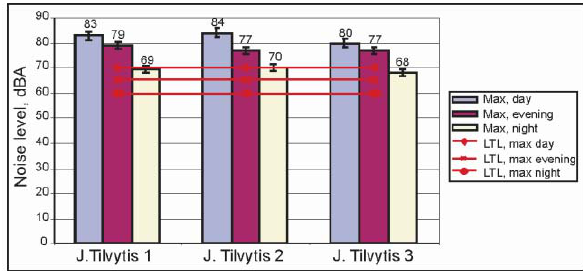
Fig. 9. Dynamics of maximum noise levels in J. Tilvytis street within twenty four hours